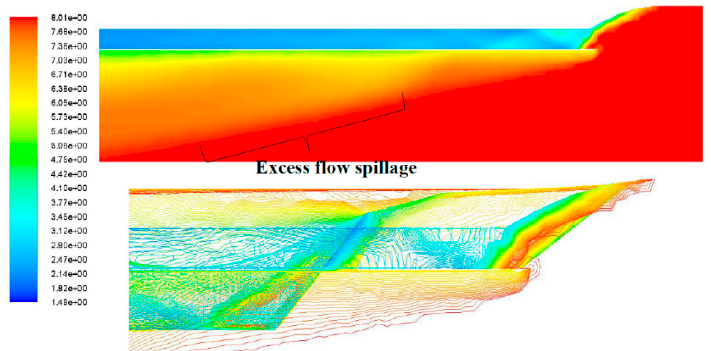
Figure 40. Mach contour of same orientation ramjet and scramjet inlets at Mach 8.